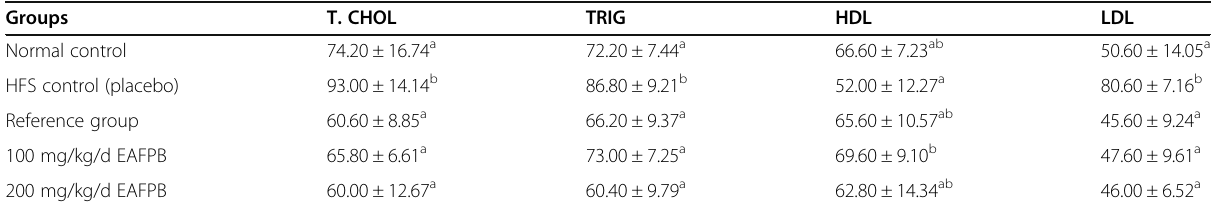
Table 5 Effect of EAFPB on lipid profile of high fructose-fed rats